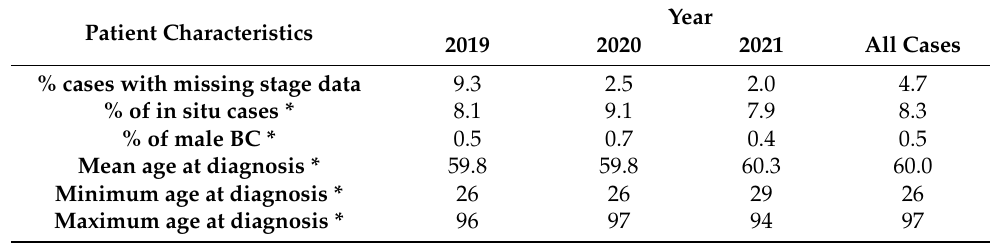
Table 2. Characteristics of BC patients reviewed by the MDT team in 2019–2021.